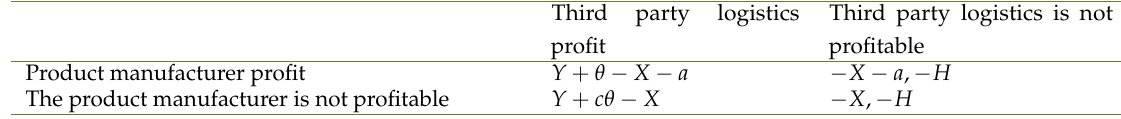
Table 2. The payoff matrix for both sides of the game